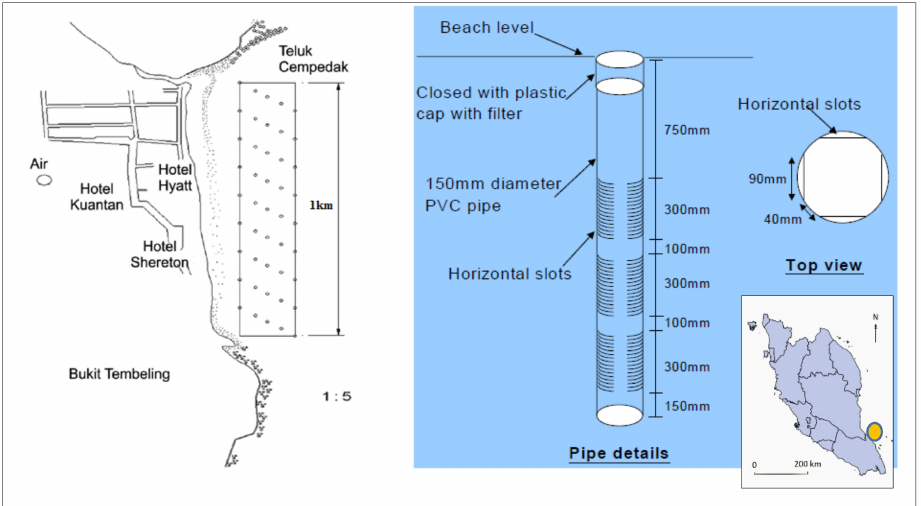
Figure 17. Innovative PEM system as beach rehabilitation in Pulau Tioman [105]. ‘Reprinted from Rehabilitation of the Beach at Teluk Cempedak, Pahang, Using Pressure Equalisation Modules (PEM) System, 2009; open access publication by IEM Repository’.